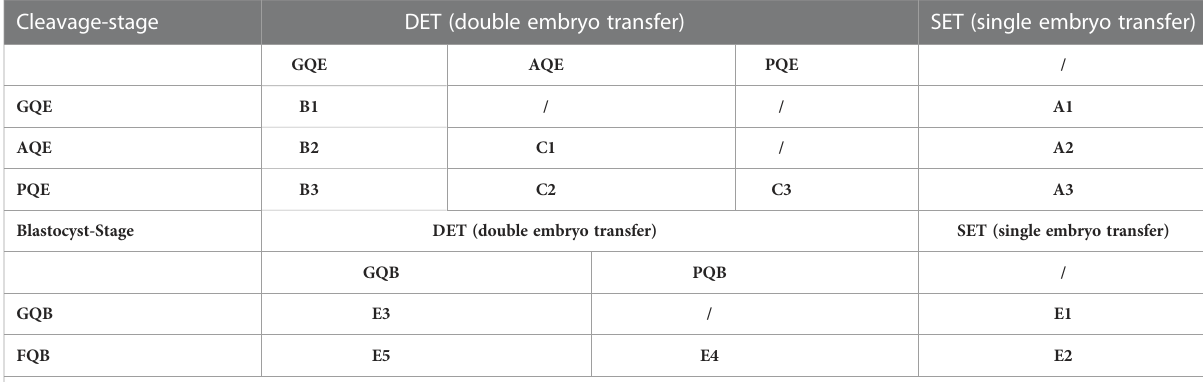
TABLE 1 Patients groups based on the number and grade of embryos transferred.